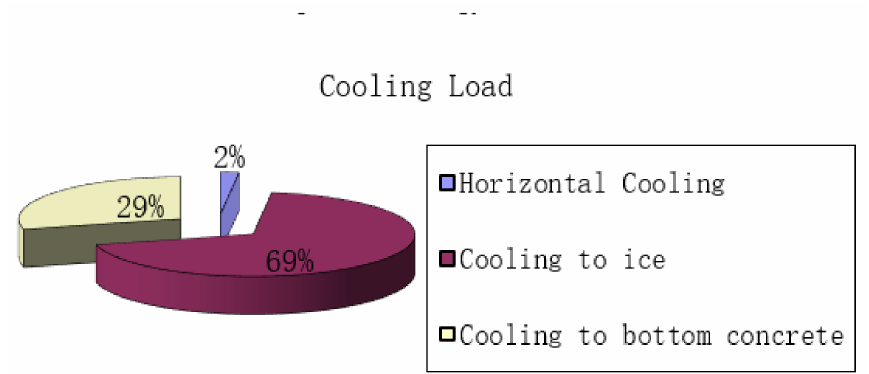
Figure 6. Proportion of heat transfer to ice, concrete, and between